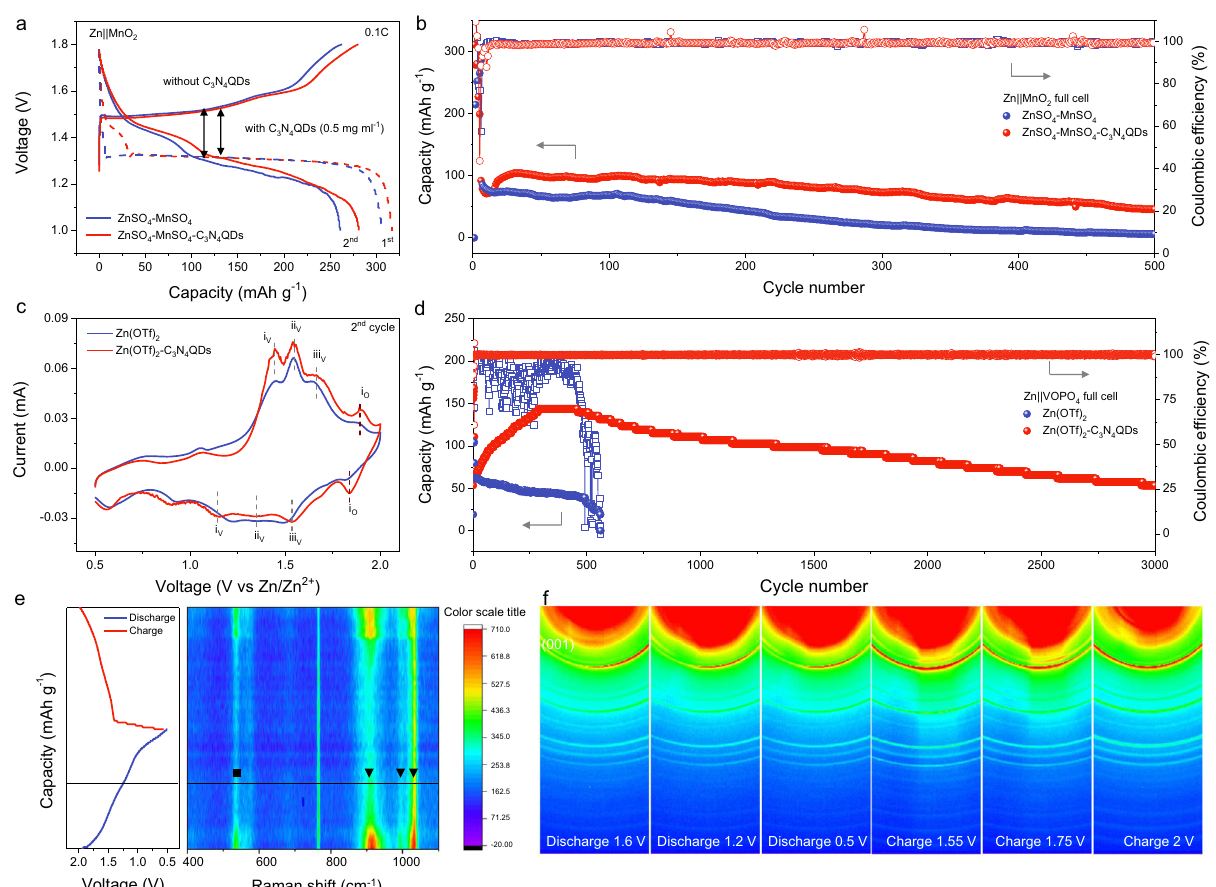
Fig. 6 | Electrochemical performance of Zn-ion full batteries. a Typical voltage pro fi lesofZn||MnO 2 andZn|C 3 N 4 QDs|MnO 2 batteriesat0.1C; b cyclicperformance of Zn||MnO 2 and Zn|C 3 N 4 QDs|MnO 2 batteries at 1C; c CV curves of Zn||VOPO 4 and Zn|C 3 N 4 QDs|VOPO 4 batteries at a scan rate of 0.1mVs − 1 ; d cyclic performance of Zn||VOPO